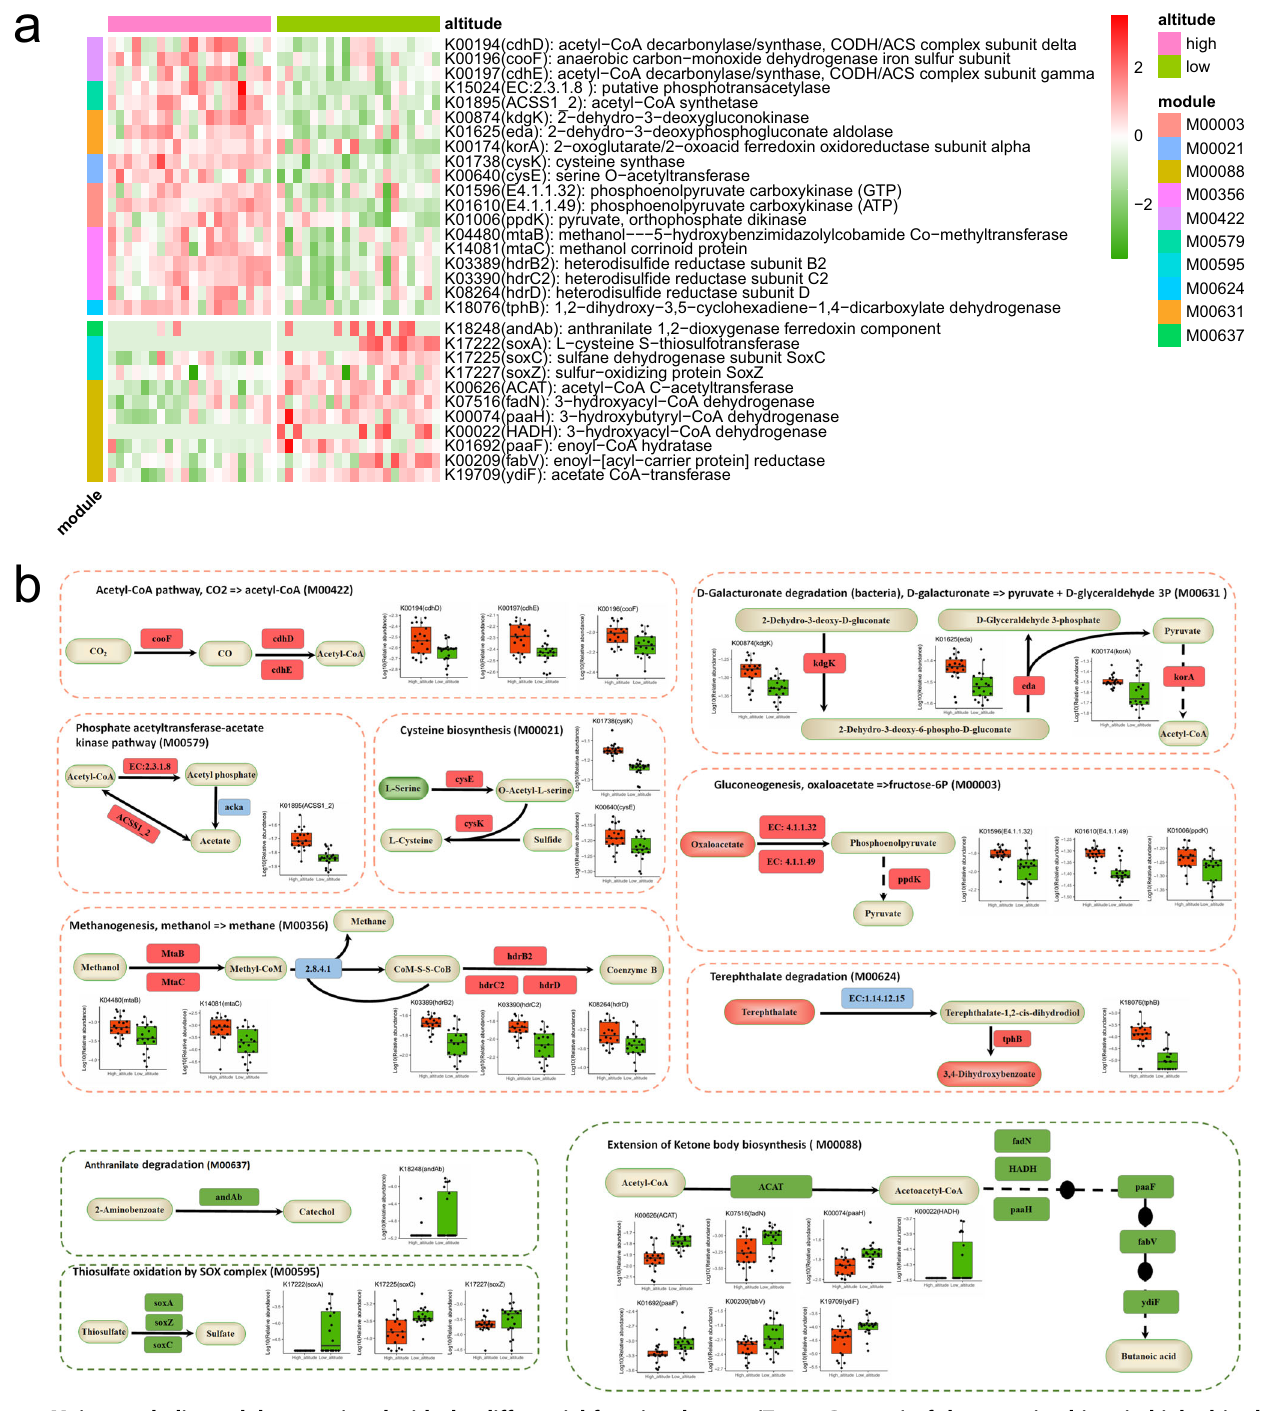
Fig. 3 Main metabolic modules associated with the differential functional genes (T-test, P < 0.05) of the gut microbiota in high-altitude populations and low-altitude populations of wild RMs. a Heatmap of major differential genes (log10 relative abundance). b Schematic diagram of main modules involved in differential genes. Red indicates that relative abundance was signi fi cantly higher in high-altitude populations. Green indicates that abundance was signi fi cantly higher in low-altitude populations. The boxes represent 25th – 75th percentiles, black lines indicate the median and whiskers extend to the maximum and minimum values within 1.5× the interquartile range, point represents the actual value of the butyrate synthesis-related ketone body biosynthesis module (M00088) extended pathway genes were signi fi cantly enriched in low-altitude populations (Fig. 3a, b). Further, the gene enrichment of these SCFA breakdown-related modules by the